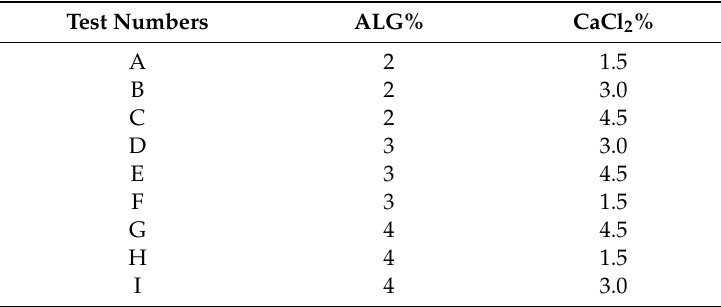
Table 2. The di ff erent composition of ALG